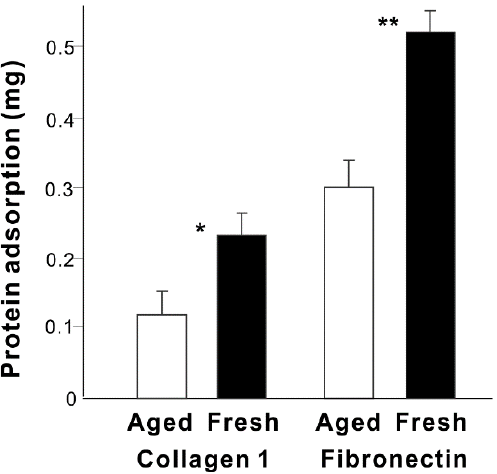
Figure 2. The ability of fresh and aged titanium surfaces to adsorb different proteins. The amount of protein adsorbed to titanium disks during a 3-h incubation is shown. * p < 0.05, ** p < 0.01, statistically significant difference between fresh and aged titanium surfaces.